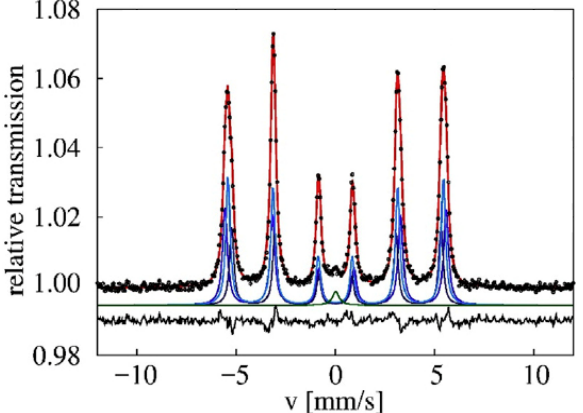
Figure 36. Conversion electron Mössbauer spectrum of Muonionalusta IVA iron meteorite measured at room temperature. Indicated spectral components are the result of the fit. The differential spectrum is shown on the bottom. Adapted from [85].